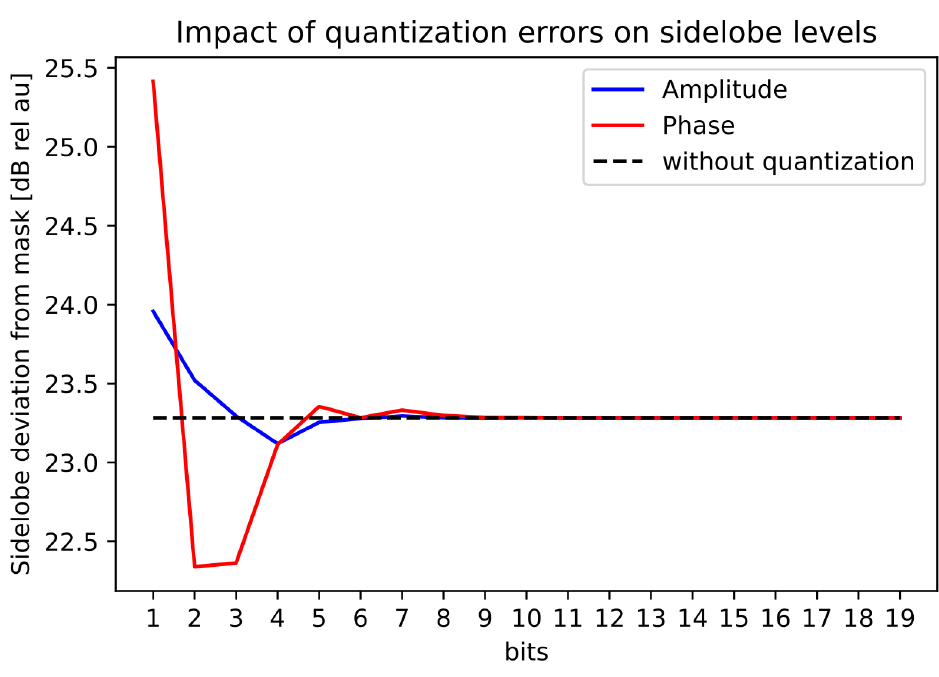
Figure 11. Quantization effect of the maximum sidelobe distance from the mask for the ramped beampattern mask with BW = 70 ◦